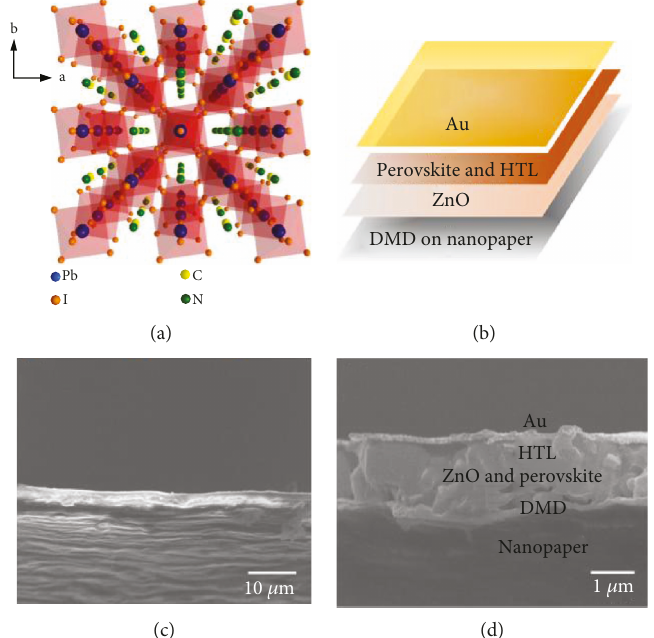
Figure 10: (a) Representation of the crystalline structure of CH (c, d) SEM micrographs representing the cross-section of the device layers with scale bar 10 μ m and 1 μ m, respectively. Device architecture: nanopaper/DMD/ZnO layer with CH